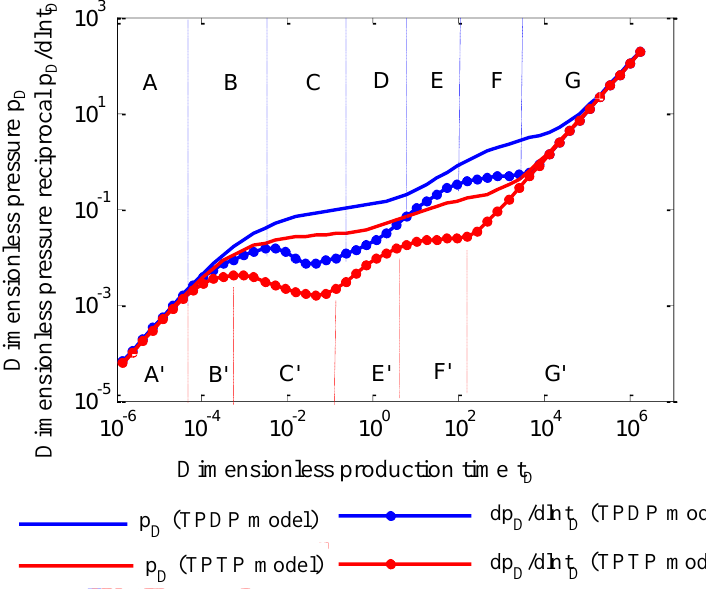
Figure 5. Type-curves of well testing for an SRV-fractured horizontal well with the TPDP and TPTP models.